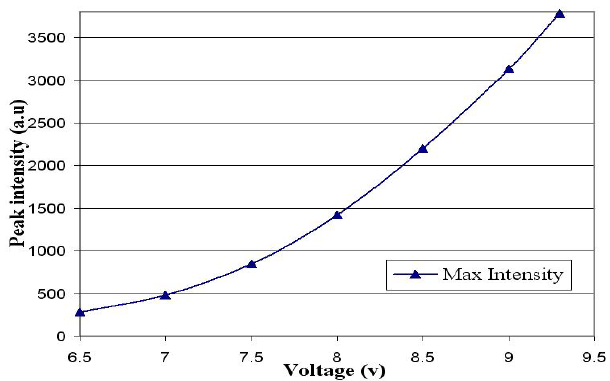
Figure 6. Stability of OLED excitation at different voltages for a peak wavelength of 496 nm.